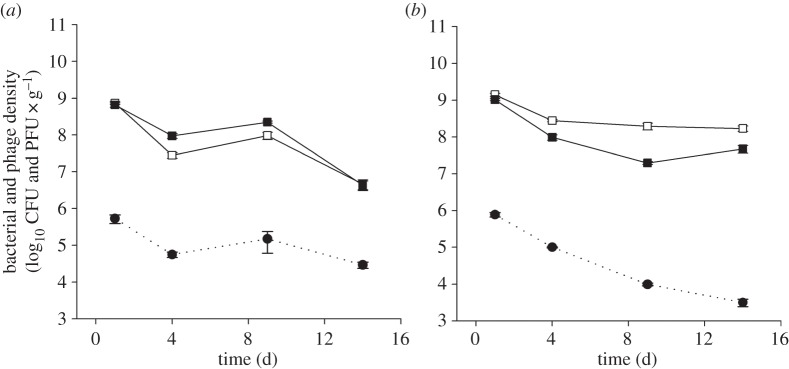
Population dynamics of bacteria and phage with the addition of nutrients. Mean densities (±s.e.m.) of P. fluorescens SBW25 (solid lines; CFUs g−1 soil) and phage SBW25φ2 (dashed lines; PFUs g−1 soil) populations with the addition of water (a) and KB media (b). Bacteria population densities were determined in the absence (unfilled squares) and presence (filled squares) of phages.